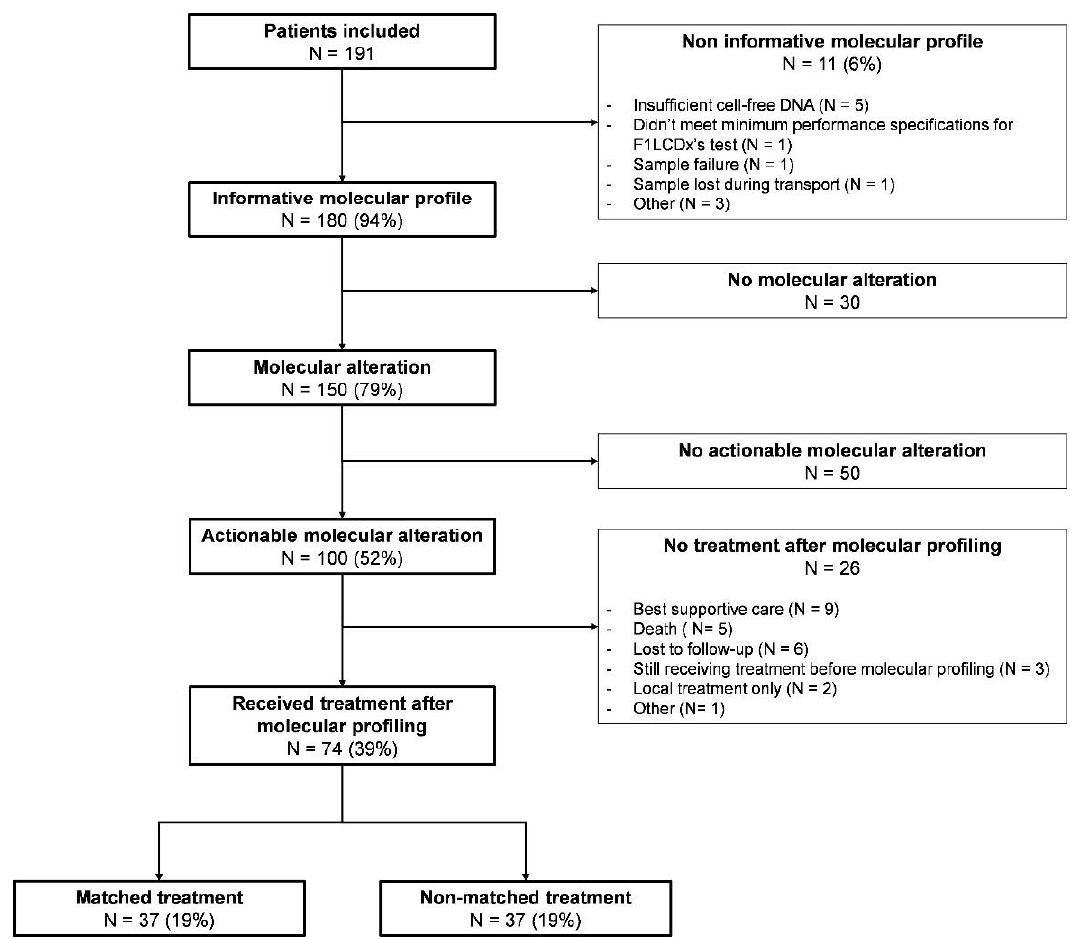
Figure 1. Study flow chart. F1LCDx: FoundationOne Liquid CDx . Table 1. Patient’s characteristics.